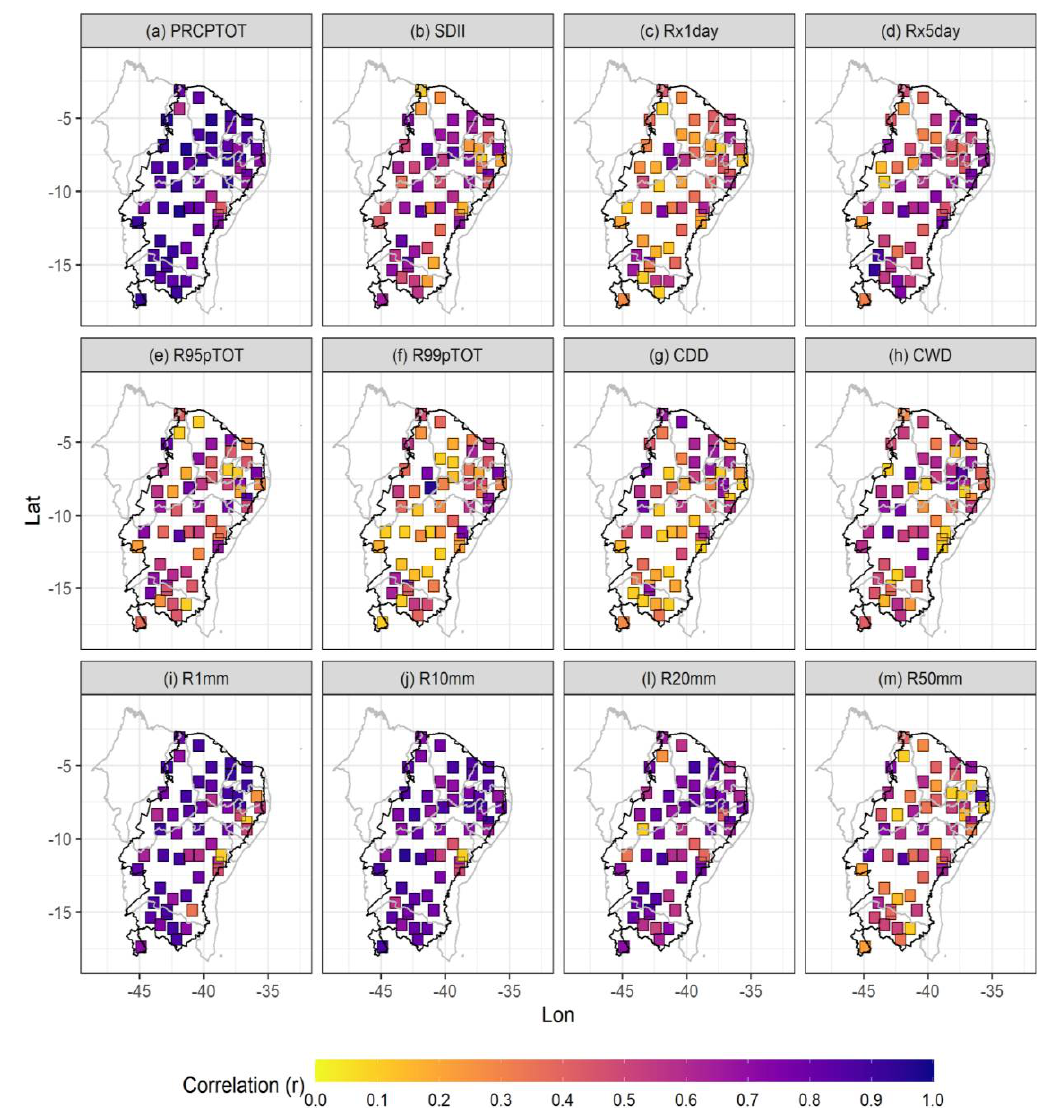
Figure 6. Spearman correlation coefficient (r) between climate indices derived from IMERG and rain gauges over a period of 21 years (2000–2020), ( a ) PRCPTPT, ( b ) SDII, ( c ) Rx1day. ( d ) Rx5day, ( e ) R95pTOT, ( f ) R99pTOT, ( g ) CDD, ( h ) CWD, ( i ) R1mm, ( j ) R10mm, ( l ) R20mm, ( m ) R50mm.